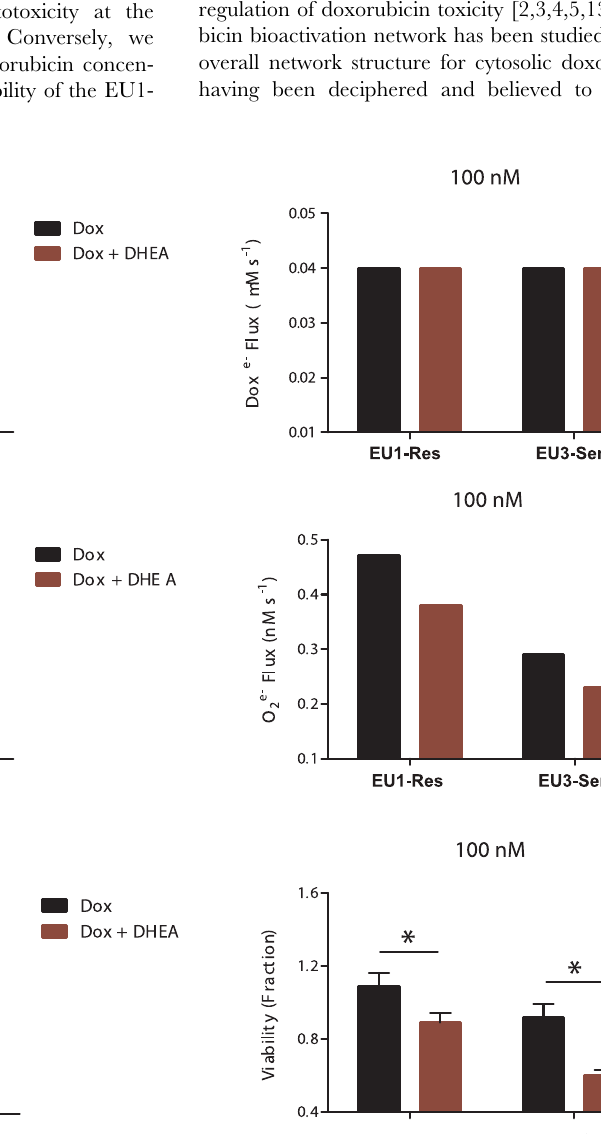
PLoS Computational Biology |